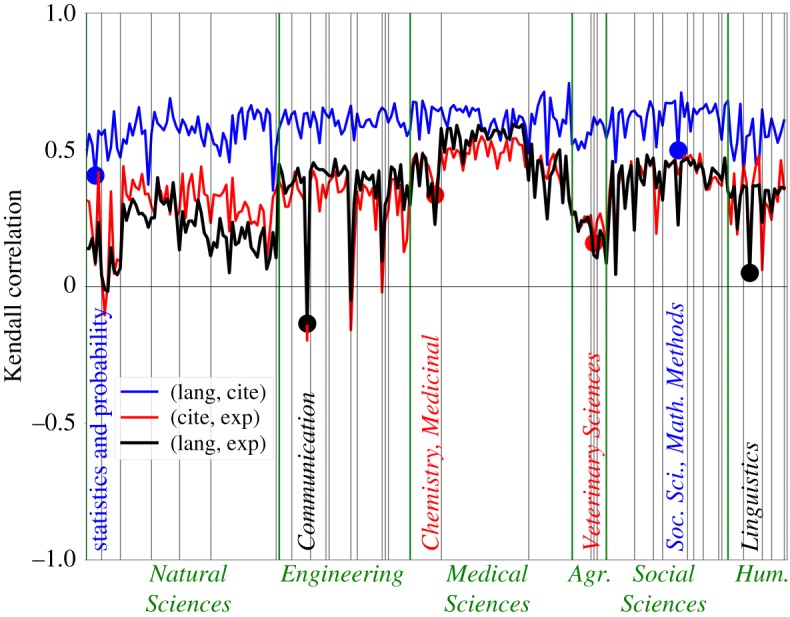
Correlation between the different dissimilarity measures varies across fields. The Kendall correlation τ(x,y) (shown in the vertical axis) for two measures x and y is computed between Dx(i,j) and Dy(i,j) over all specialties j for a fixed specialty i (shown in the horizontal axis). The three possible comparisons (x,y) are indicated in the caption. Six specialties (one from each domain) with low correlation are highlighted.